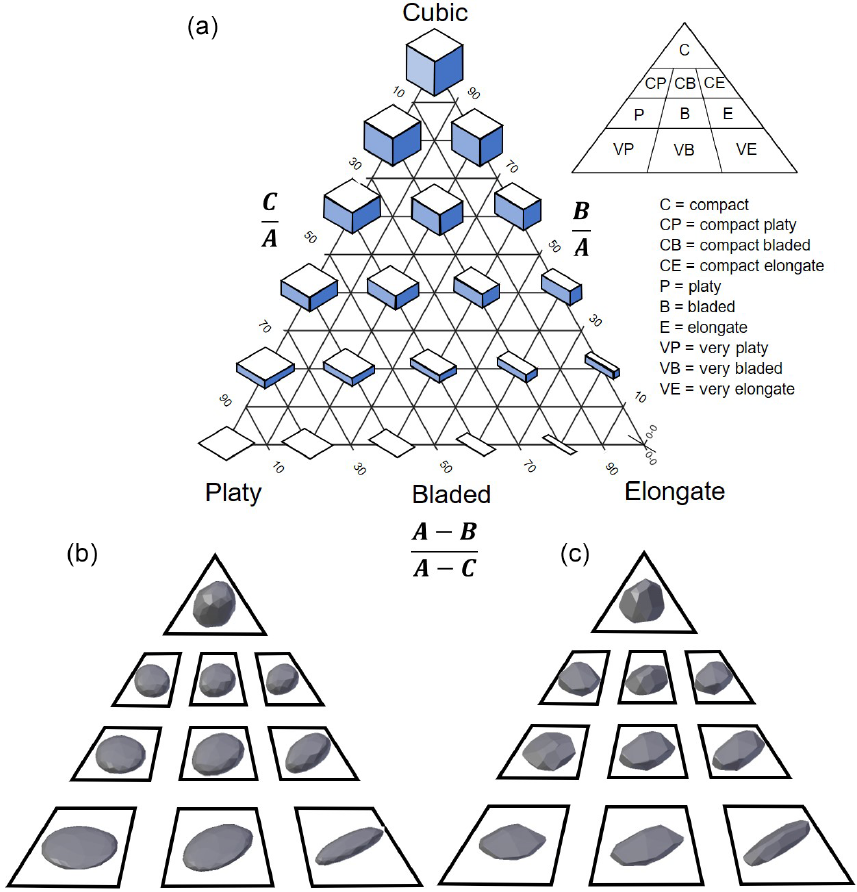
Figure 1. Overview of the Sneed and Folk ternary diagram adapted from Blott and Pye (2008). (a) Visual representation of the different shape forms as defined by Sneed and Folk (1958). Inset diagrams display the divisions for each shape class. (b) Overview of the rounded synthetic blocks generated using Blender. (c) Overview of the angular blocks generated using